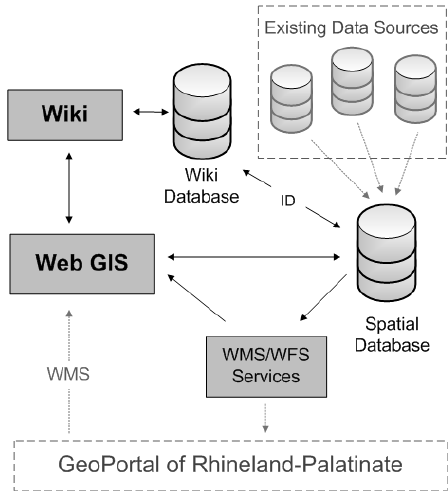
Figure 2. KuLIS System Design.